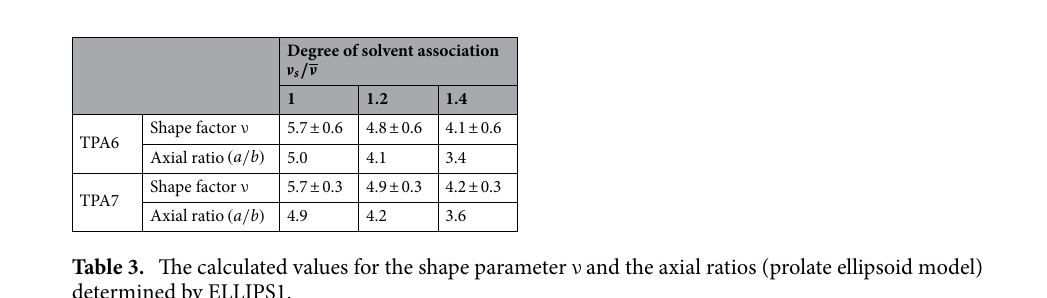
Figure 6. MultiSig analyses of the molar mass distribution f( M ) vs M w of ( a ) TPA6 and ( b ) TPA7 at a loading concentration of 4.0 mg/mL. Rotational speed = 45,000 rpm.